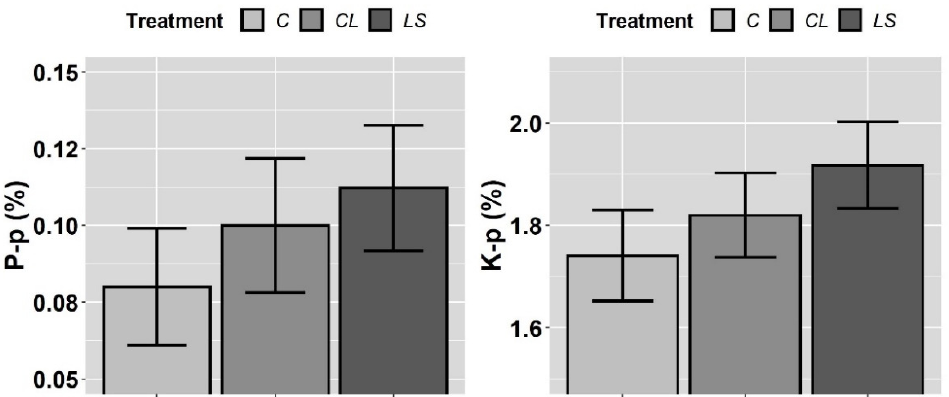
Figure 5. Mean values of the petiole nutrient contents of phosphorus (P-p) and potassium (K-p) for each treatment. Treatments: control (C), control of leonardite (CL), and leonardite mixed with ferrous sulphate heptahydrate (LS). Error bars reflect the SE of the mean (±1 SE mean).